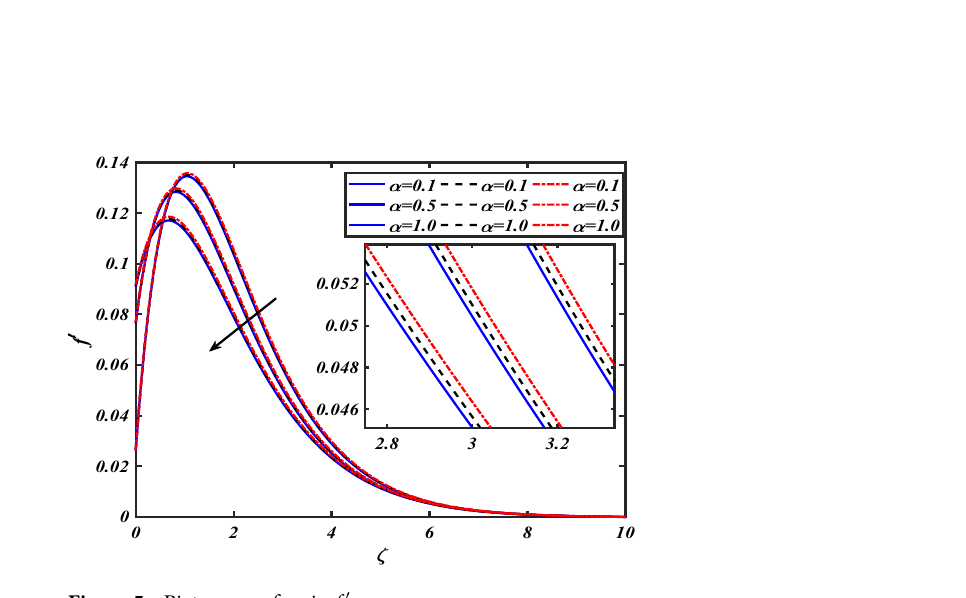
Figure 5. Pictogram of α via f ′